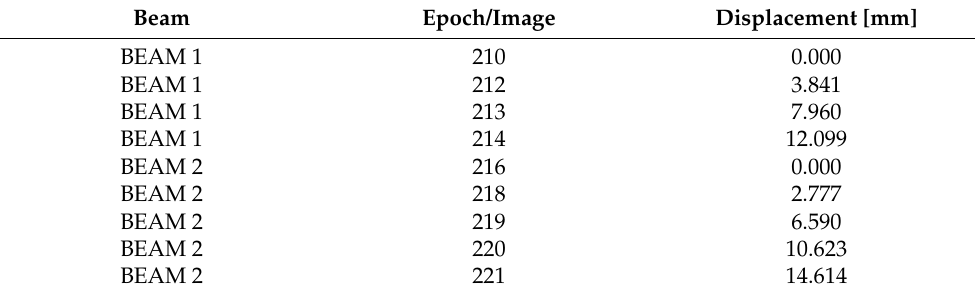
Table 2. Measurement epoch and LVDT measured displacement.